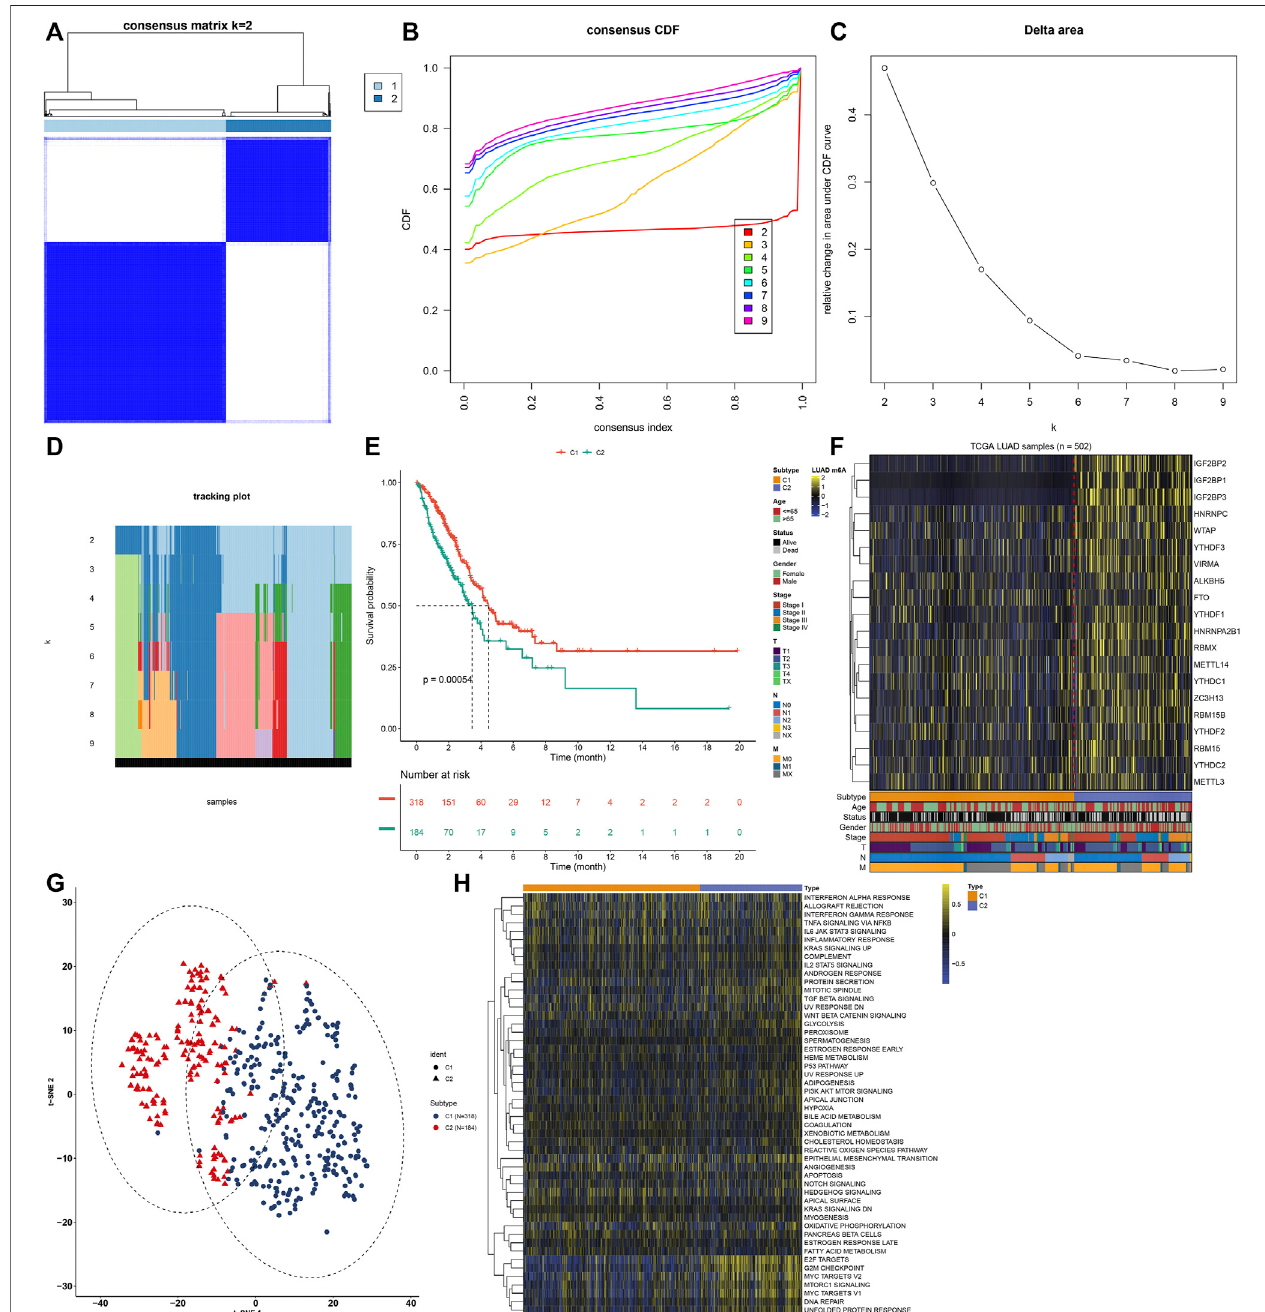
FIGURE2| Constructionofm 6 Aregulator-mediatedm 6 Amodi fi cationpatternsinLUADfromtheTCGAcohort. (A) Consensusmatrixwhennumberofgroups(k) (cid:1) 2. Intheconsensus matrix,whitemeantthatsampleswereimpossibly clusteredtogether,and darkbluemeantthatsampleswerealways clustered together.Bothrows and columns of the matrix represented samples. (B) Consensus cumulative distribution function (CDF) diagram when different k values. (C) Delta area plot for relative changeintheareaunderCDF curve forkcomparedtok-1. (D) Tracking plotforsampleclusteringwhen differentk values. (E) Kaplan-Meier curvesofOSbetween two m 6 A modi fi cation patterns. The survival probabilities were compared with log-rank test. (F) Heatmap for the expression patterns of 20 m 6 A regulators in different m 6 A modi fi cation patterns, age, survival status, gender, stage, T, N and M. (G) The t-SNE plots for verifying the differences between two m 6 A modi fi cation patterns. (H) GSVA for the activation of signaling pathways in LUAD samples between two m 6 A modi fi cation patterns.